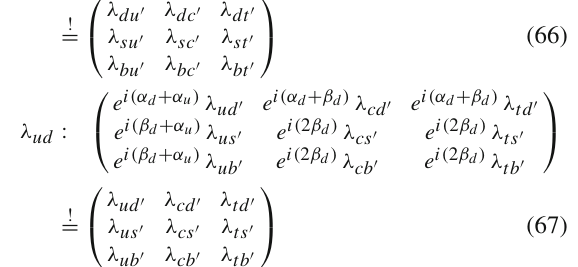
Table 5 Simplified models of flavourful leptoquarks determined after symmetryandexperimentalconstraintsareapplied.Thesecondcolumn gives the set of couplings as defined in (45) and (58). The fourth column gives all phases that must be set equal to one another for the scalar and λ QL Phase equalities Notes Isolation